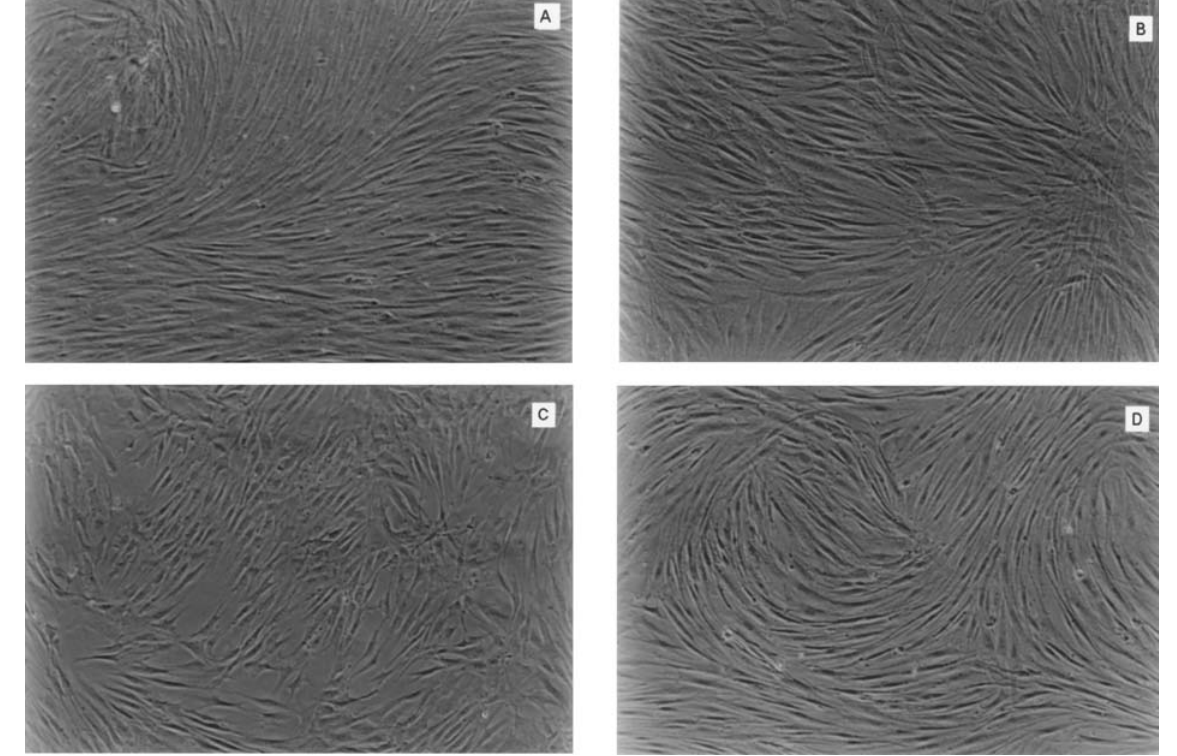
Figure 3 - Photograph of fibroblasts without (a) and after clindamycin 1 µ g/mL (b), 2 µ g/mL (c) and 3 µ g/mL (d) addition. (X